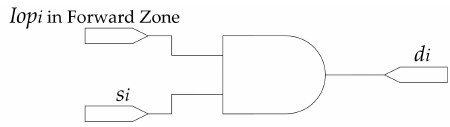
Figure 5. Logic scheme for the determination of d i